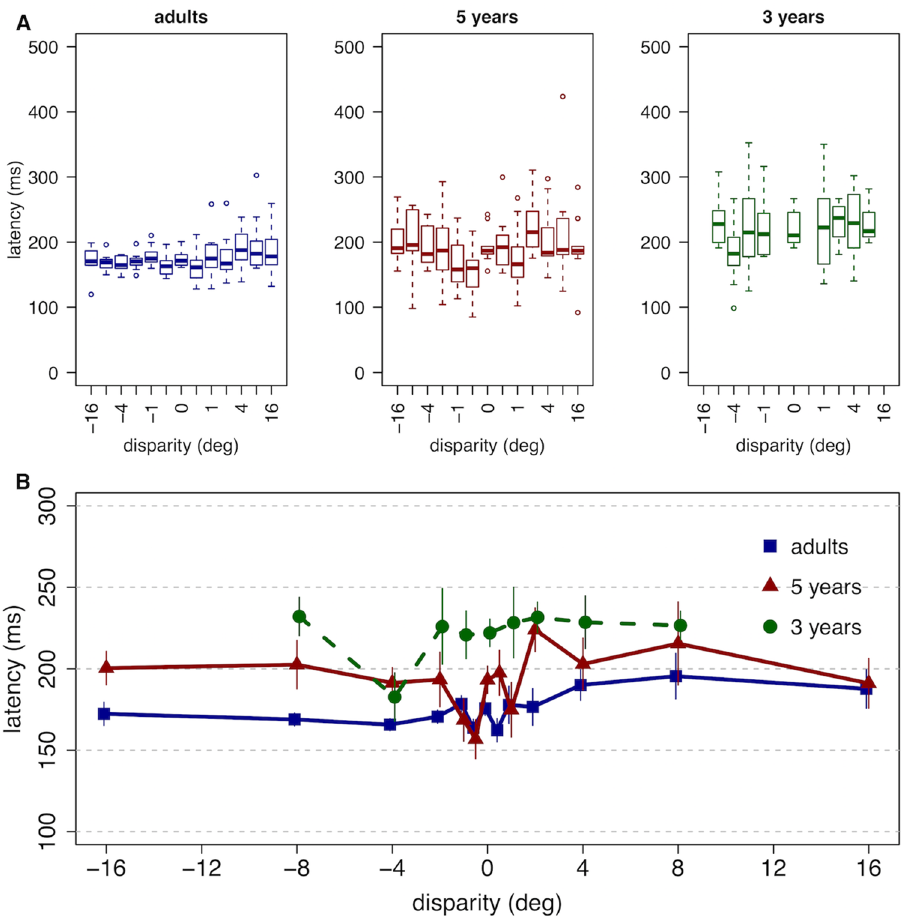
Figure 3. The latency between the step in stimulus disparity and initiation of the vergence response (T L ). ( A ) The distributions of individual participant latencies, with median values, as a function of disparity step size for each age group (n = 10 per group). ( B ) Mean latency as a function of disparity step size for each group. Error bars reflect standard error. In all plots, the value plotted at a disparity of 0 reflects the mean latency across all trials, since no vergence movement is elicited from these stimuli.